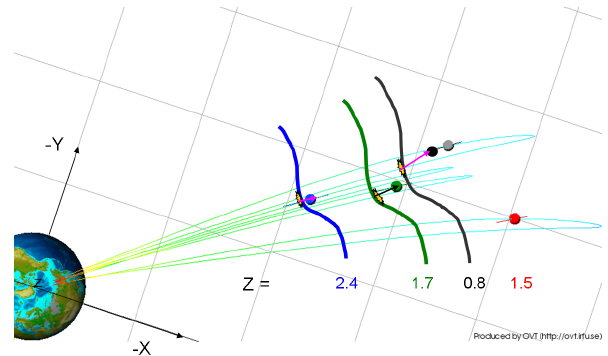
Figure 9. OVT view in XOY plane of SM coordinates, on 26 Au- gust 2008, at 16:50UT. The Cluster satellites C1, C2, C3 and C4 are shown respectively as grey, red, green and blue cylinders, and intercepted field lines are drawn in light colours (red to blue, ac- cording to magnetic field magnitude). The black cylinder represents C1 at 16:36UT. Cuts of the plasmapause at Z positions (in R E ) of NTC sources viewed by C4 and C3 at 16:50UT and by C1 at 16:36UT are sketched by thick lines respectively in blue, green and black. Possible sources are sketched by yellow stars. Pink arrows are aligned with indicative orientations of the ray path derived from directivity